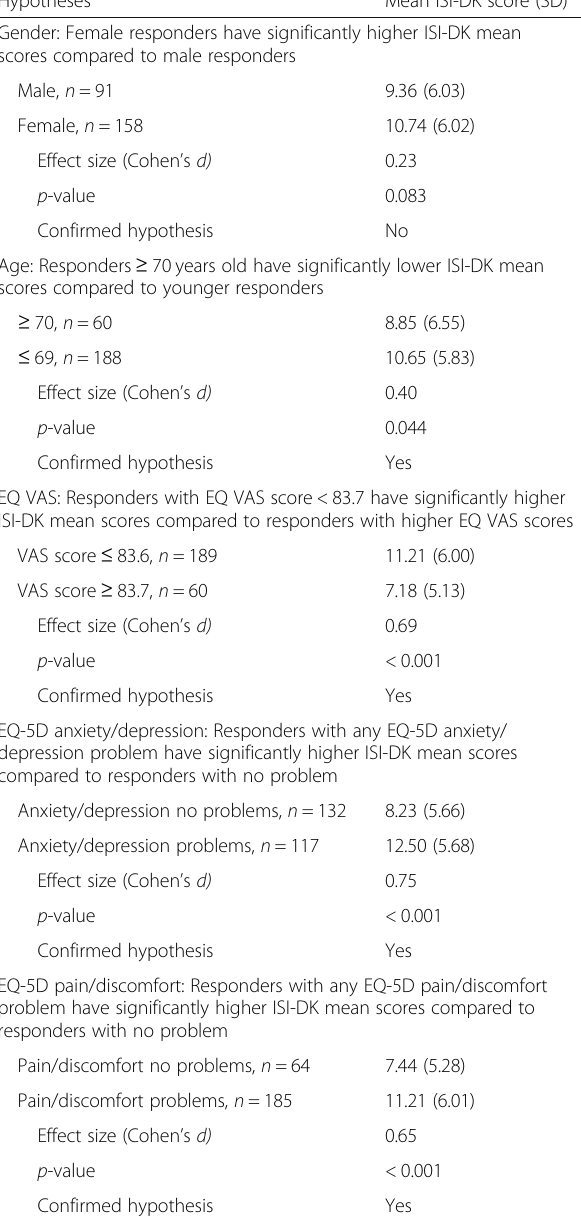
Table 3 Discriminative validity of the Insomnia Severity Index Danish version (ISI-DK)